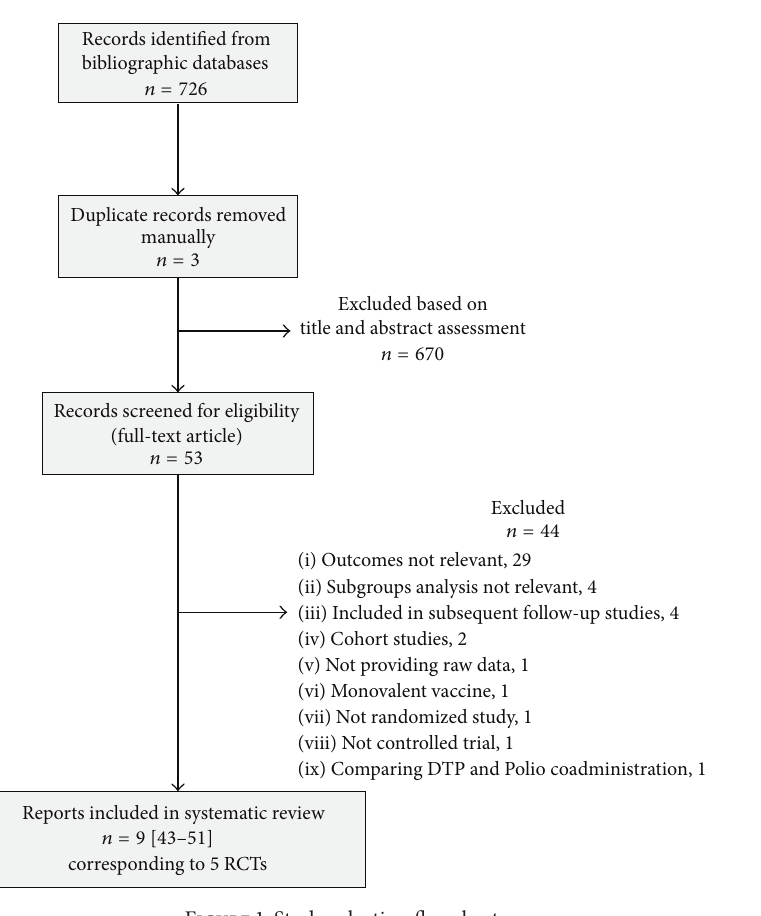
Figure 1: Study selection